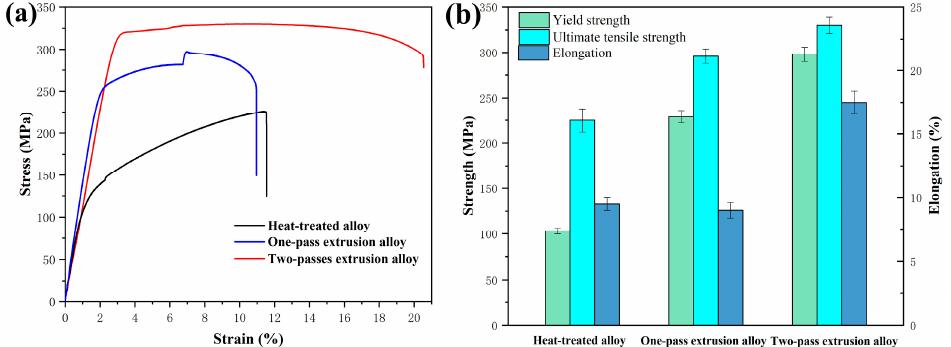
Figure 9. ( a ) Tensile true stress–true strain curves of the Mg–Zn–Y–Nd alloys with different states, ( b ) variation of mechanical properties of the Mg–Zn–Y–Nd alloys with different states. Table 2. The detailed mechanical properties of the Mg–Zn–Y–Nd alloys with different states. YS (MPa) UTS (MPa) E (%)